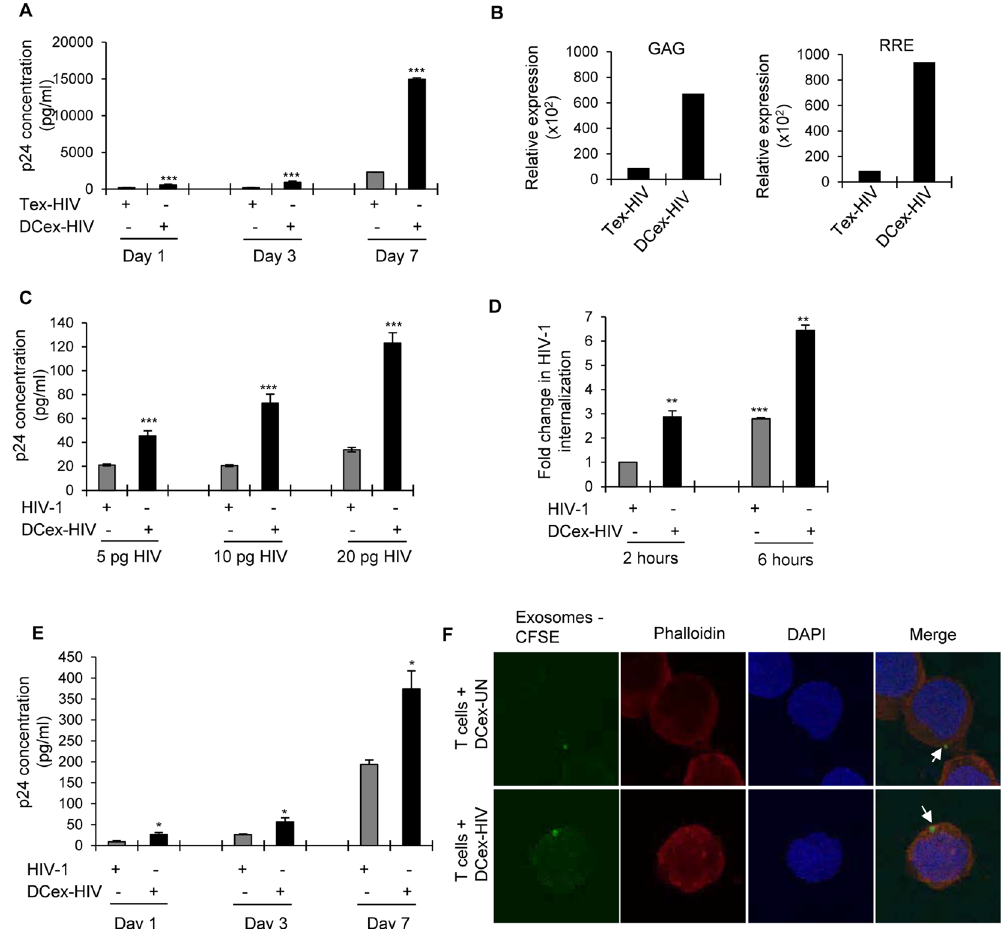
Figure 2. Analysis of HIV-1 infectivity of T cells mediated by exosomes derived from HIV-1 infected T cells and DCs. ( A ) CD63 + ve exosomes isolated from HIV-1 infected T cells (Tex-HIV) or DCs (DCex-HIV) were cultured with T cells and cell supernatants were analyzed for HIV-1 p24 titer on days 1, 3, and 7 by using ELISA ( *** p ≤ 0.001, p-values for day 1 – 0.00066, day 3 – 0.00006, day 7 – 0.000147). ( B ) Total RNA was isolated from Tex-HIV and DCex-HIV incubated with T cells on day 7. Expression of HIV-1 genes GAG and RRE was assessed by qRT-PCR. ( C ) T cells were incubated with equal amounts (p24 titer) of CD63 + ve DCex-HIV and cell free virus with indicated doses for 3 days and cell supernatants were analyzed for HIV-1 p24 titer using ELISA ( *** p ≤ 0.001, p-values for CD63 + ve DCex-HIV 5 pg – 0.000714, 10 pg – 0.000294, 20 pg – 0.000062). ( D ) Bar diagram showing HIV-1 internalization in target T cells incubated with cell free HIV-1 or exosomes derived from HIV-1 infected DCs at indicated time points. Fold change was calculated by considering internalization in HIV-1 treated cells as 1 ( ** p ≤ 0.01, *** p ≤ 0.001, p-values for DCex-HIV 2 hours – 0.0089, 6 hours – 0.002099, HIV-1 6 hours – 0.000325). ( E ) T cells were incubated with equal amounts (p24 titer) of CD81 + ve DCex-HIV and cell free virus for 7 days and cell supernatants were analyzed for HIV-1 p24 titer at day 1, 3 and 7 using ELISA ( * p ≤ 0.05, p-values for DCex-HIV Day 1–0.0475, Day 3–0.0466, Day 7–0.0293. ( F ) Confocal images of exosomes internalization by T cells: DCex-UN and DCex-HIV were labelled with CFSE (green), incubated with T cells for 1 hour; cells were stained for Phalloidin (red) and analyzed by confocal microscopy (Arrow indicates exosomes). Results are representative of 3 independent